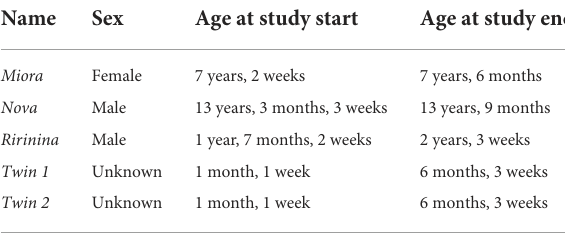
TABLE 1 Jersey Zoo study group.